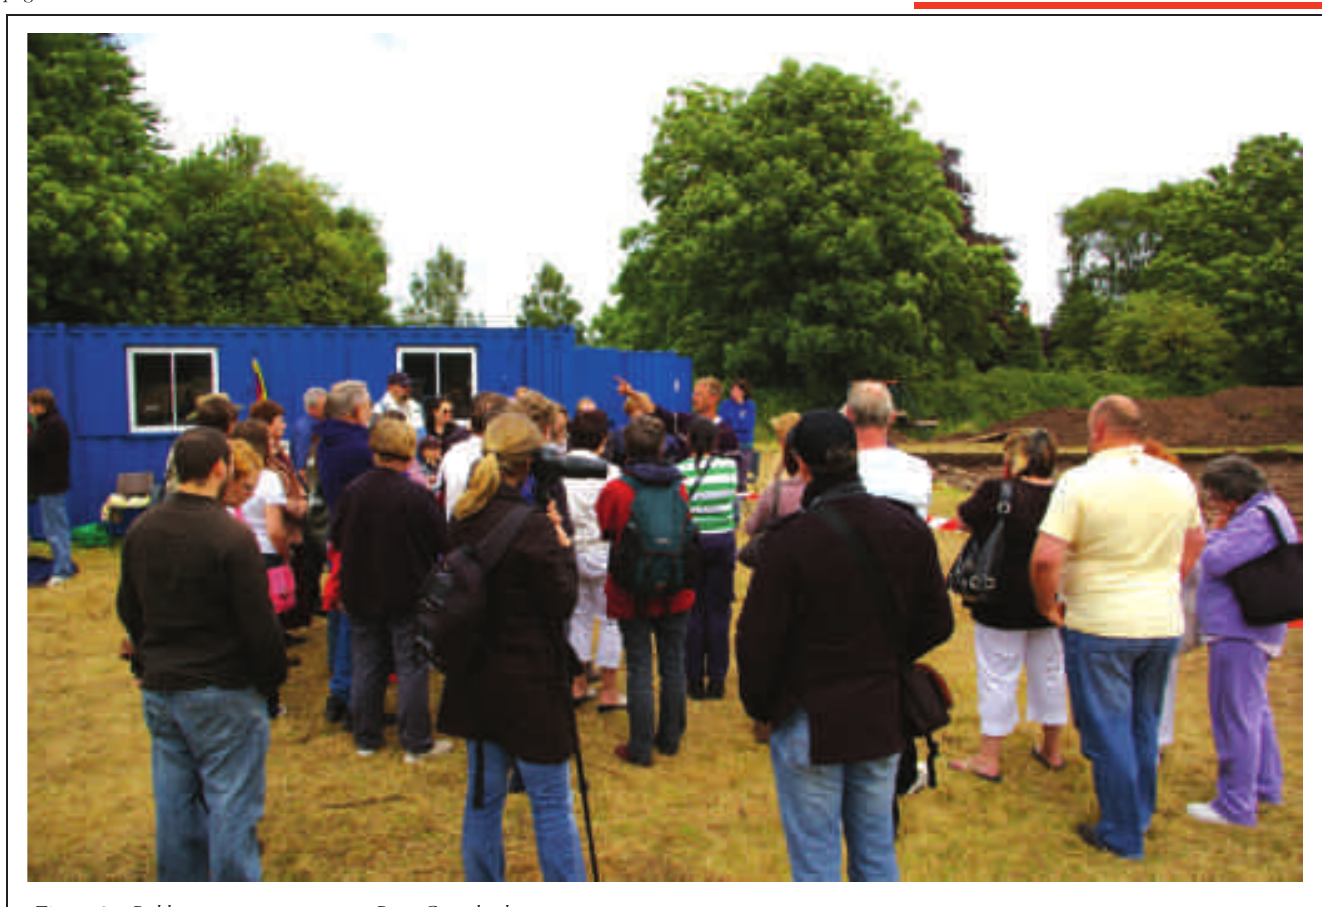
Figure 9 Public engagement activities: Peter Guest leading a site